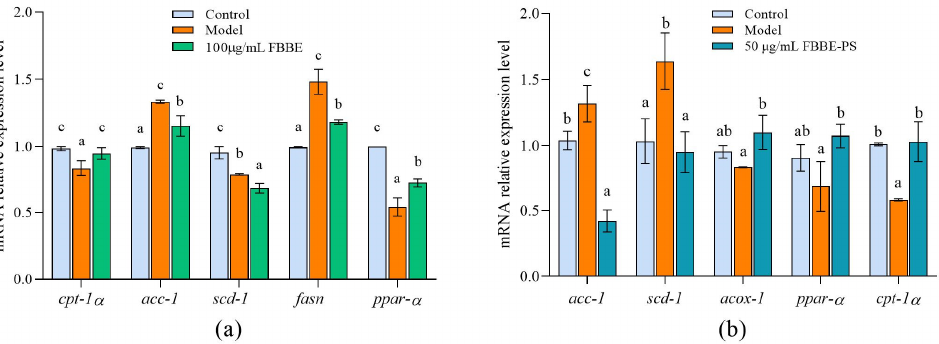
Figure 3. Effects of FBBE (100 µ g/mL) ( a ) and FBBE-PS (50 µ g/mL) ( b ) on the expression of genes related to fat metabolism in HepG2 cells. Data are presented as means ± SD, n = 3, different letters indicate significant differences between groups ( p < 0.05).